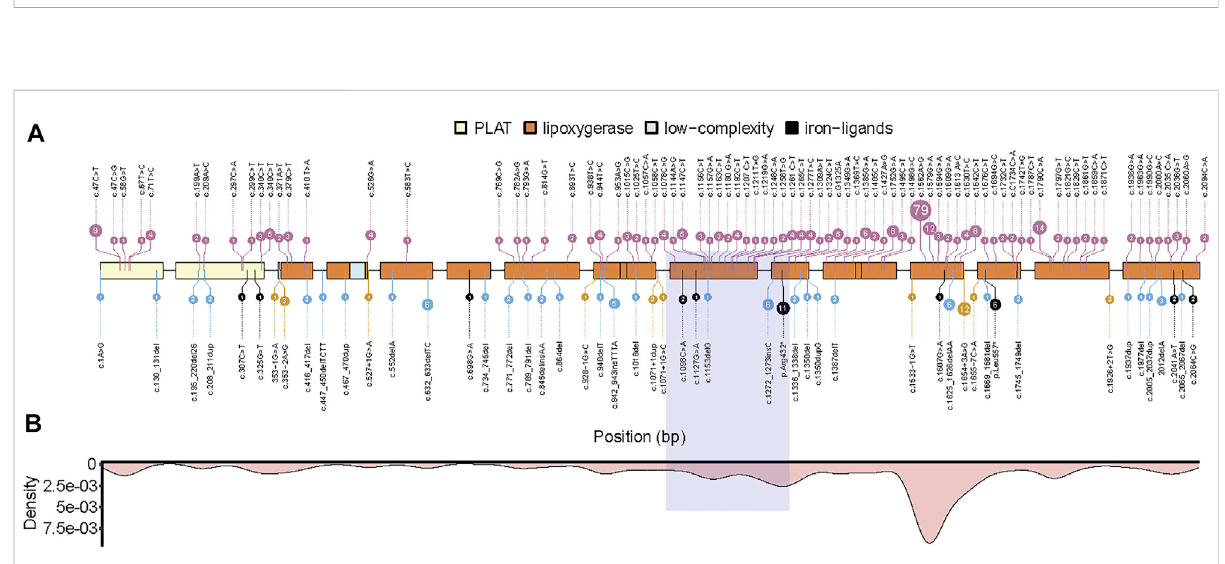
FIGURE 3 Summary of pathogenic mutations in ALOX12B . (A) ALOX12B domains, exons, and site of variants (missense mutations in pink, frameshift mutations in blue, nonsense mutations in black, and splicing mutations in yellow). (B) The density plot of all mutations is shown below, and the light purple box represents the deletion in this case. PLAT: polycystin-1, lipoxygenase, α -toxin